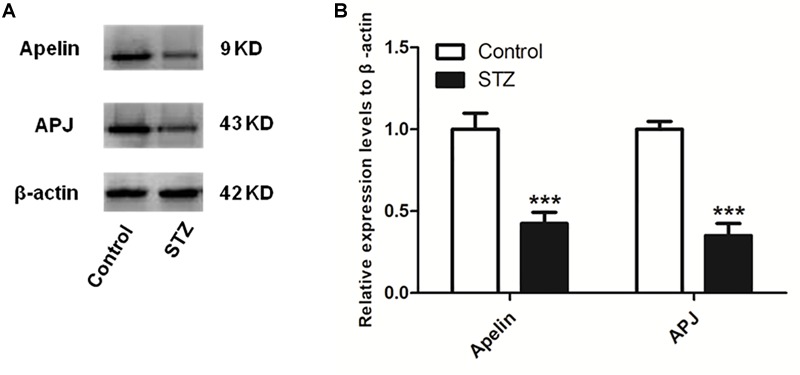
The expression levels of apelin and APJ decreases in the hippocampus of STZ-induced SAD rats. (A) Representative western blot analysis of apelin and APJ levels in the hippocampus. (B) Quantification of apelin and APJ relative to β-actin in control and STZ groups of rats. All data are presented as mean ± SEM. ∗∗∗p < 0.001 comparison to control rats, N = 4.